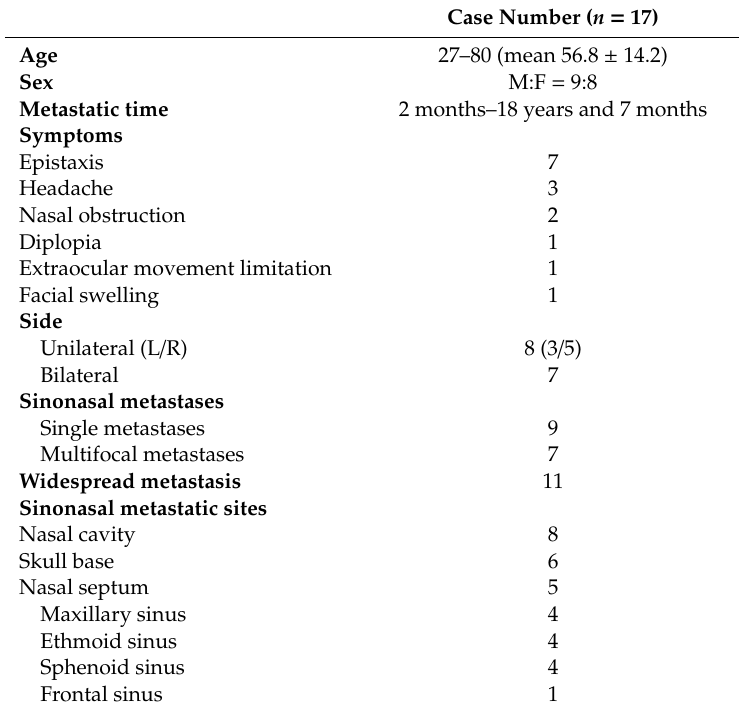
Table 1. The demographic and clinical characteristics of the patients and the